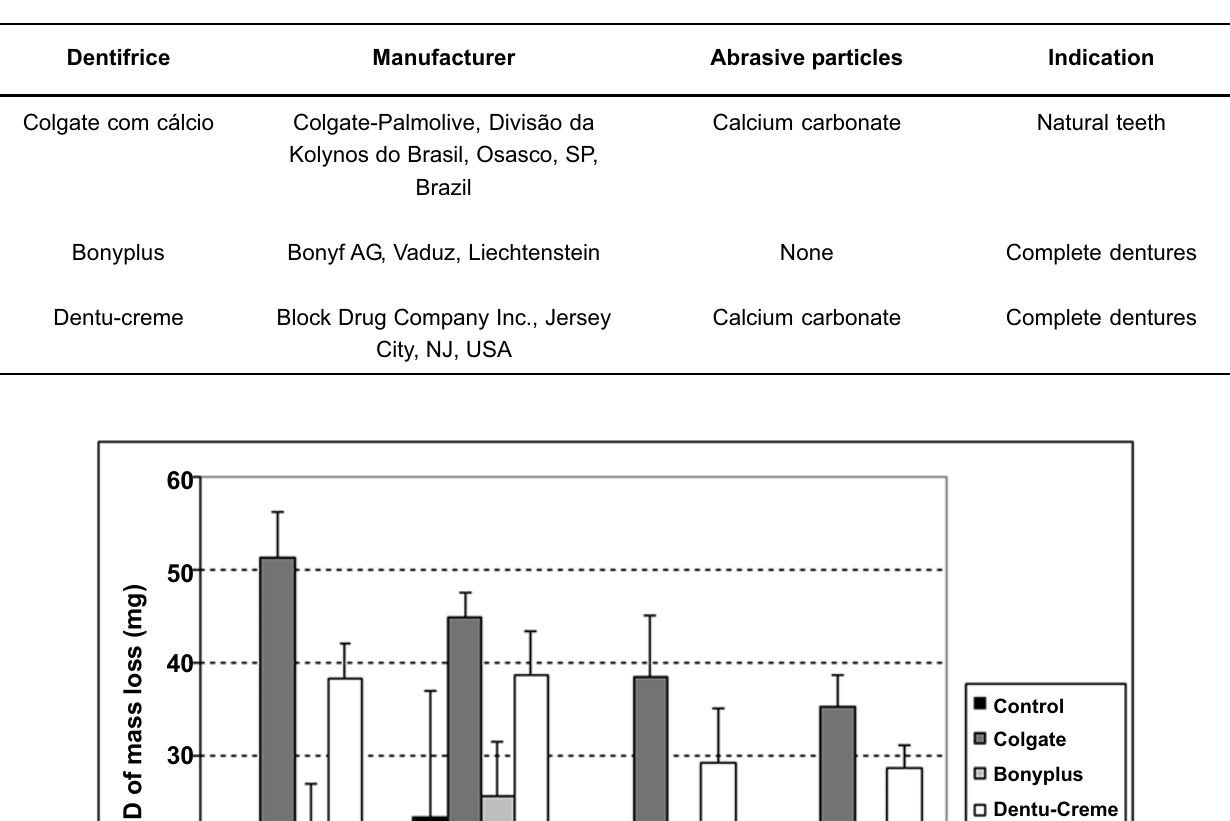
TABLE 2- Characteristics of tested dentifrices